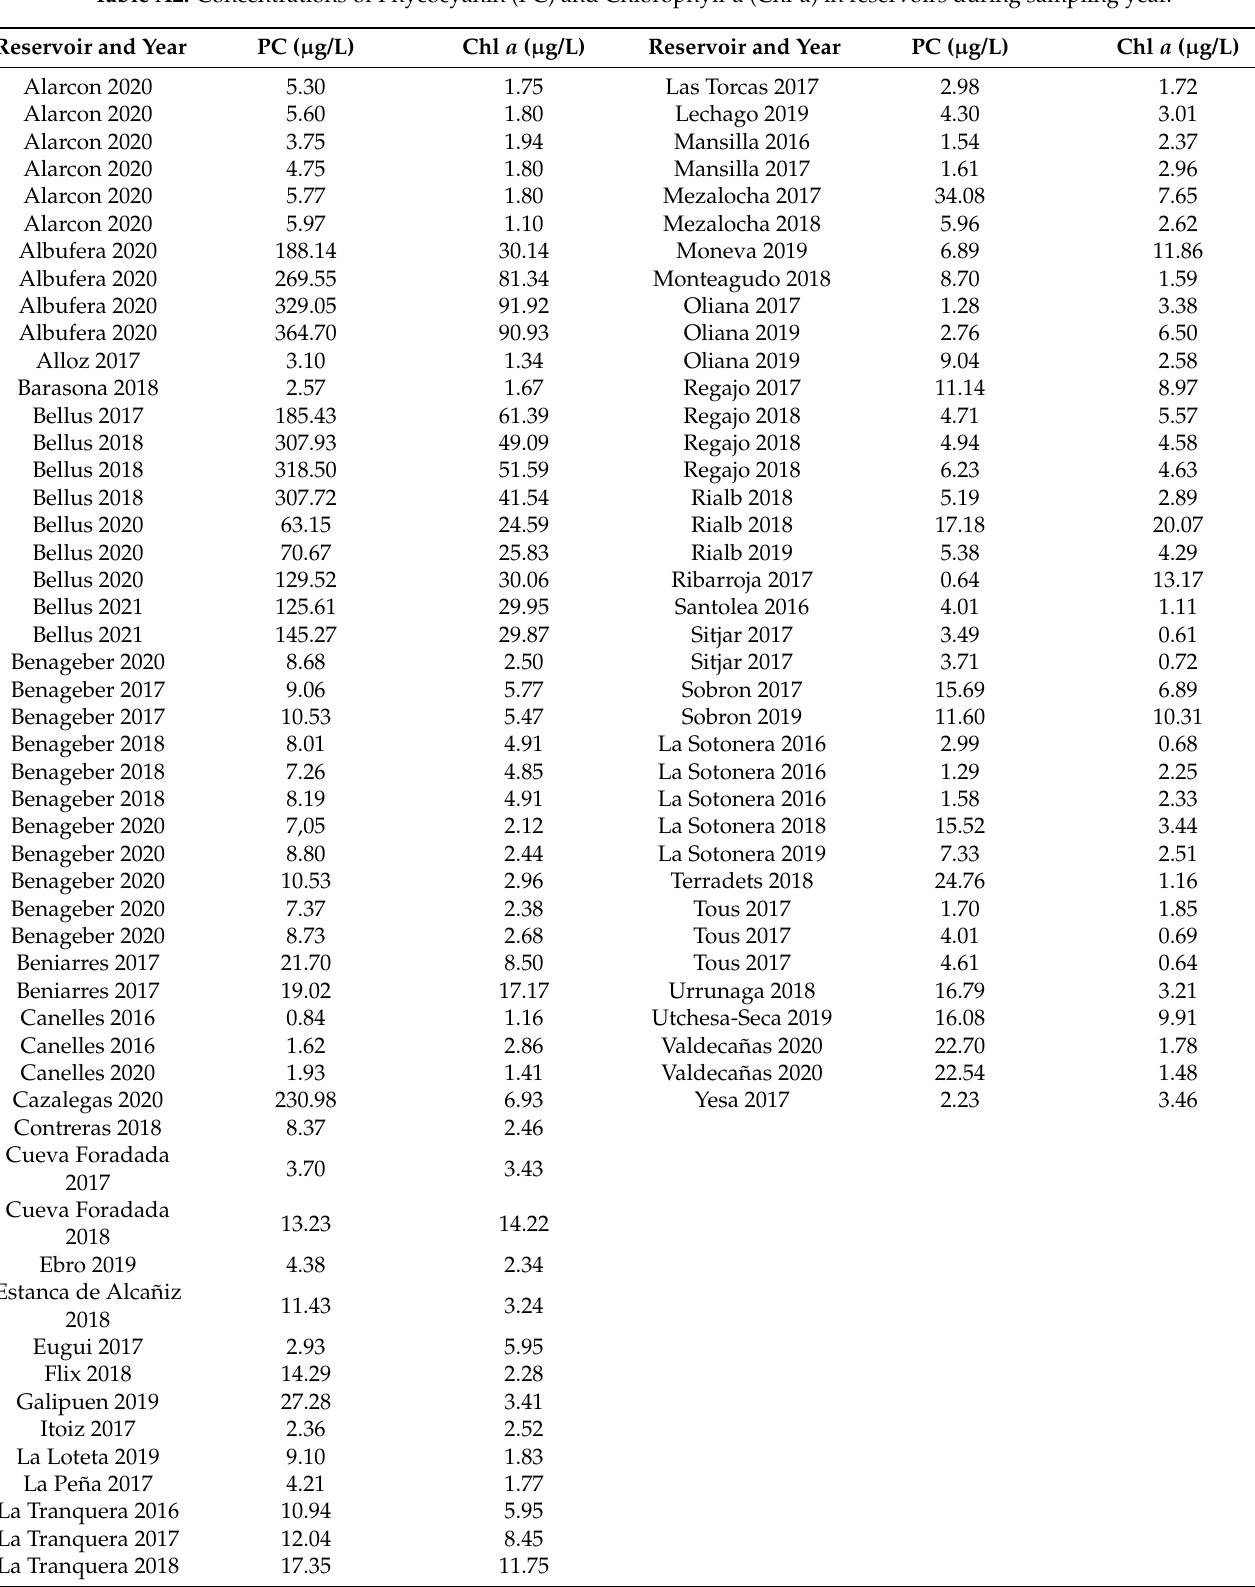
Table A2. Concentrations of Phycocyanin (PC) and Chlorophyll-a (Chl-a) in reservoirs during sampling year. Reservoir and